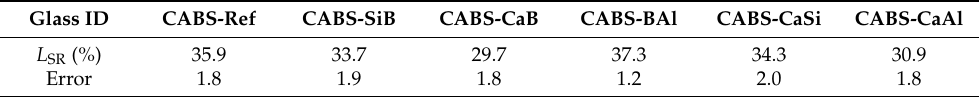
Table 7. Indentation side recovery ( L SR ) for the as-made calcium aluminoborosilicate glasses. The reported L SR value and corresponding error are based on results from ten independent